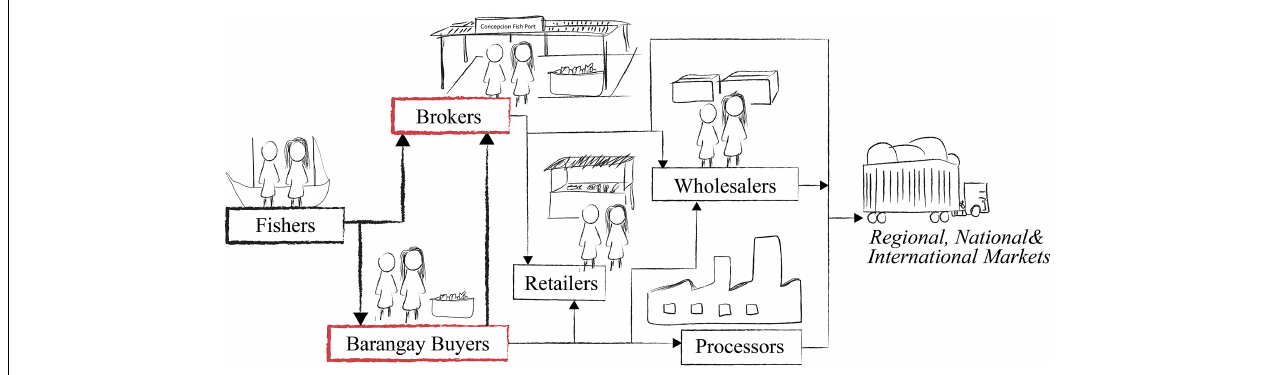
FIGURE 3 | Conceptualization of the market system in the Concepcion Municipality, Philippines. Arrows represent the sales paths of the product being sold. The larger more bolded lines and arrows represent the actors in this paper and study – the fishers, barangay buyers, and brokers. The red indicates the patrons.